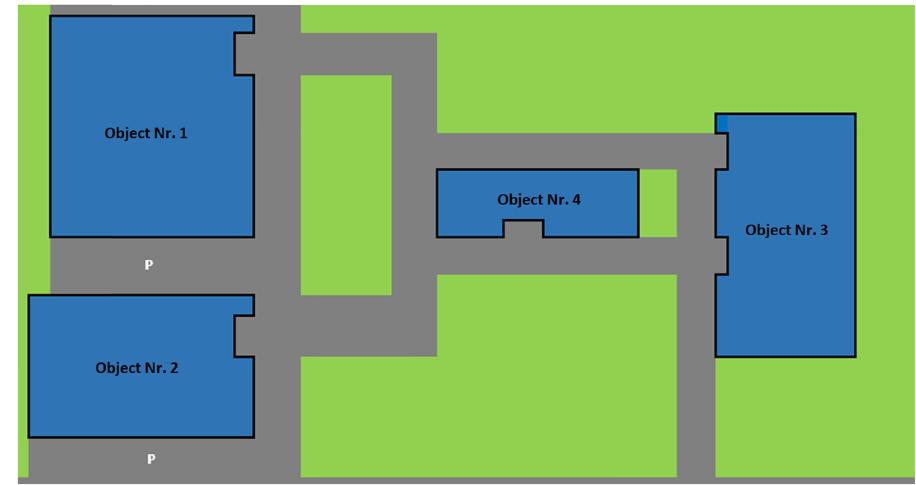
Figure 4: Premises of the company during the deployment of a tugger